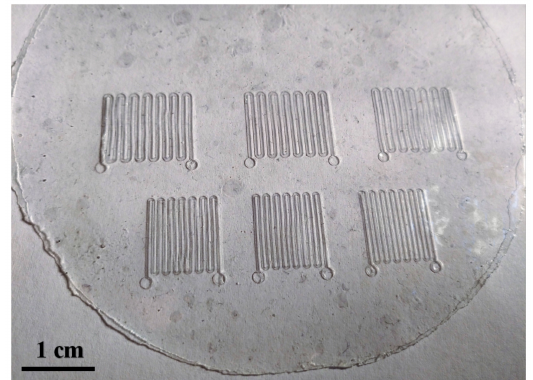
Figure 4. Overall, six microfluidic chips are fabricated simultaneously with PDMS-PDMS bonded film.